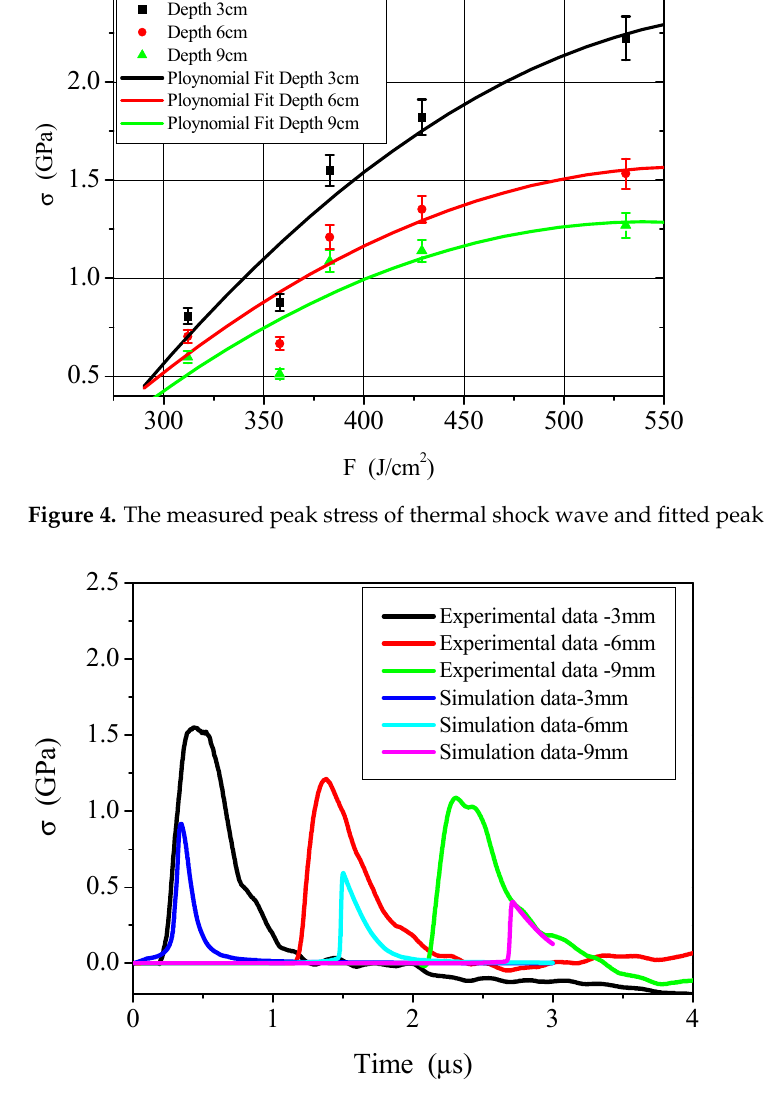
Figure 5. A comparison of C/P material experiment and calculation data.